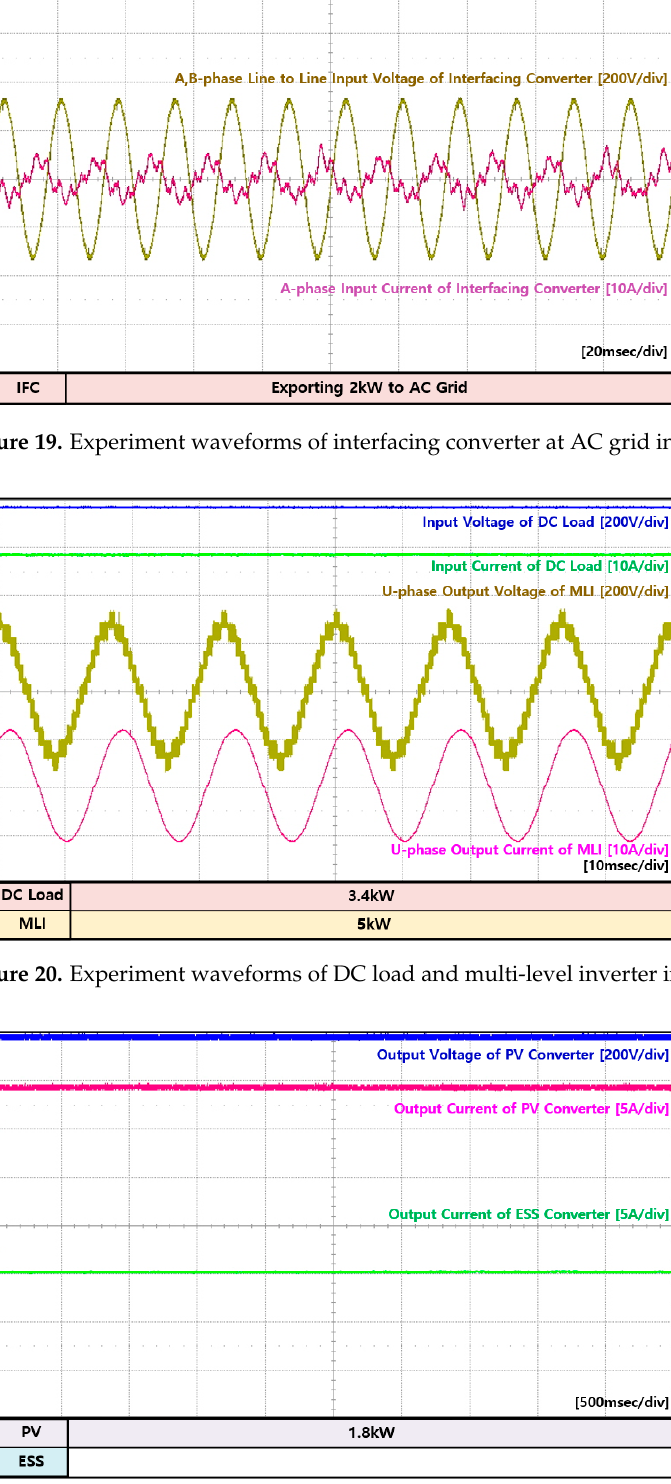
Figure 18. Experiment waveforms of interfacing converter and WT converter in mode 3.